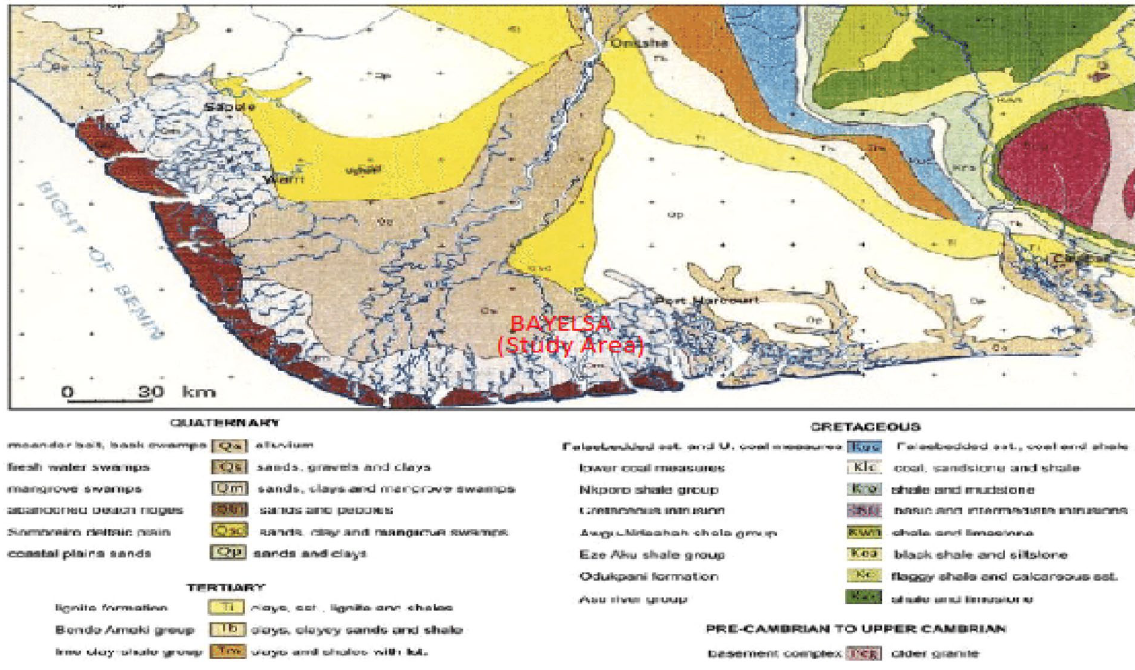
Figure 2. Geologic Map of the Study Area 19